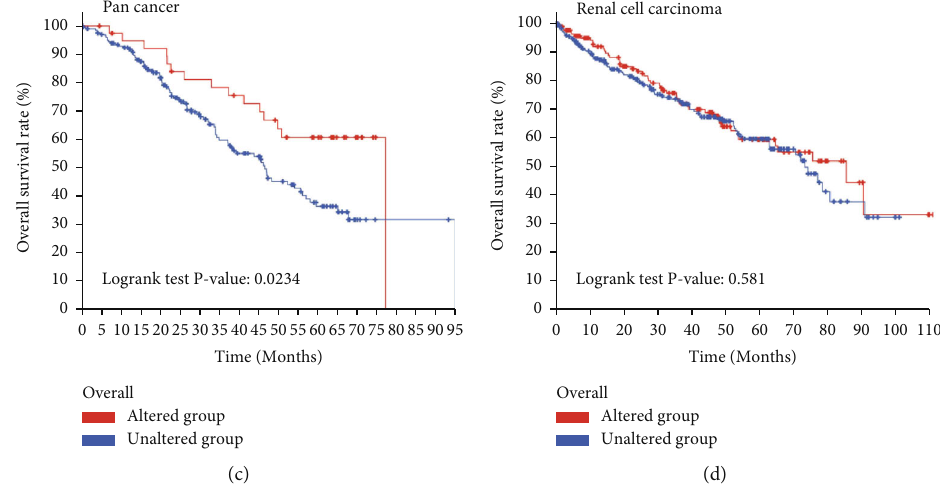
Figure 3: Transformation characteristics in PBRM1 in various tumors of TCGA. (a) Transformation frequency in PBRM1 in pan-cancer. (b) The change frequency of PBRM1 mutation types and mutation sites in TCGA tumors was demonstrated by cBioPortal tool. (c, d) Potential correlation between transformation status and overall survival of pan-cancer and renal cell cancer conducted by the cBioPortal